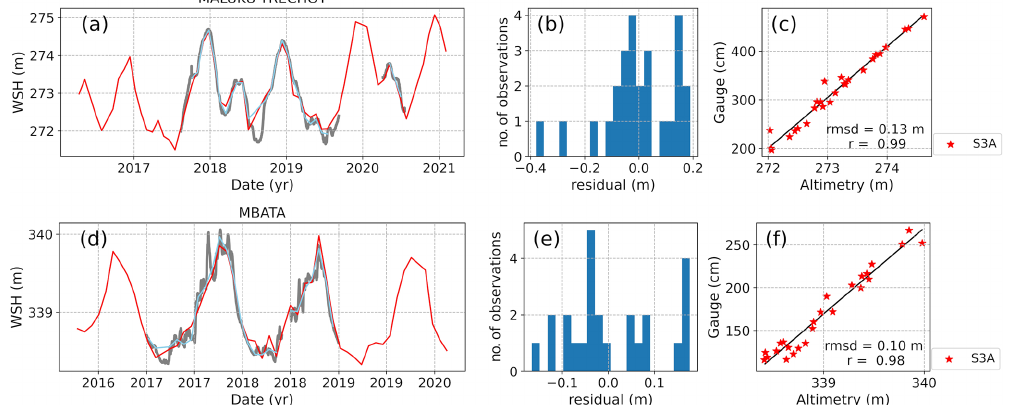
Figure 4. Similar to Fig. 3 but the in situ stations are located right below the satellite track of S3A. A comparison of the in situ water stage (Table 1) and S3A altimeter-derived SWH at different sites is shown (see Fig. 1 for their locations). (a, d) The time series of both in situ and altimetry-derived water heights, where the grey line in the background shows the in situ daily WS variations (grey), and the sky blue line indicates the in situ WS sampled at the same date as the altimeter-derived SWH from S3A (red) mission. (b, e) The histogram of the difference between the altimeter-derived SWH and the in situ WS. (c, f) The scatterplot between altimeter-derived SWH and in situ WS. The linear correlation coefficient r and the root mean square deviation (rmsd), considering all the observations, are indicated. The solid line shows the linear regression between both variables.